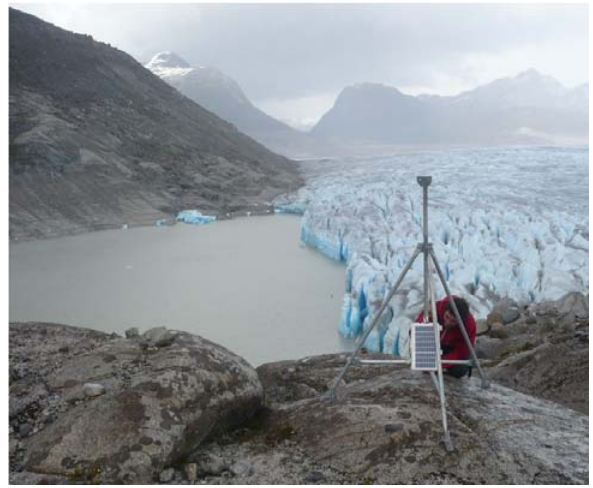
Figure 3: Harbortronics camera installation at Lago Nef